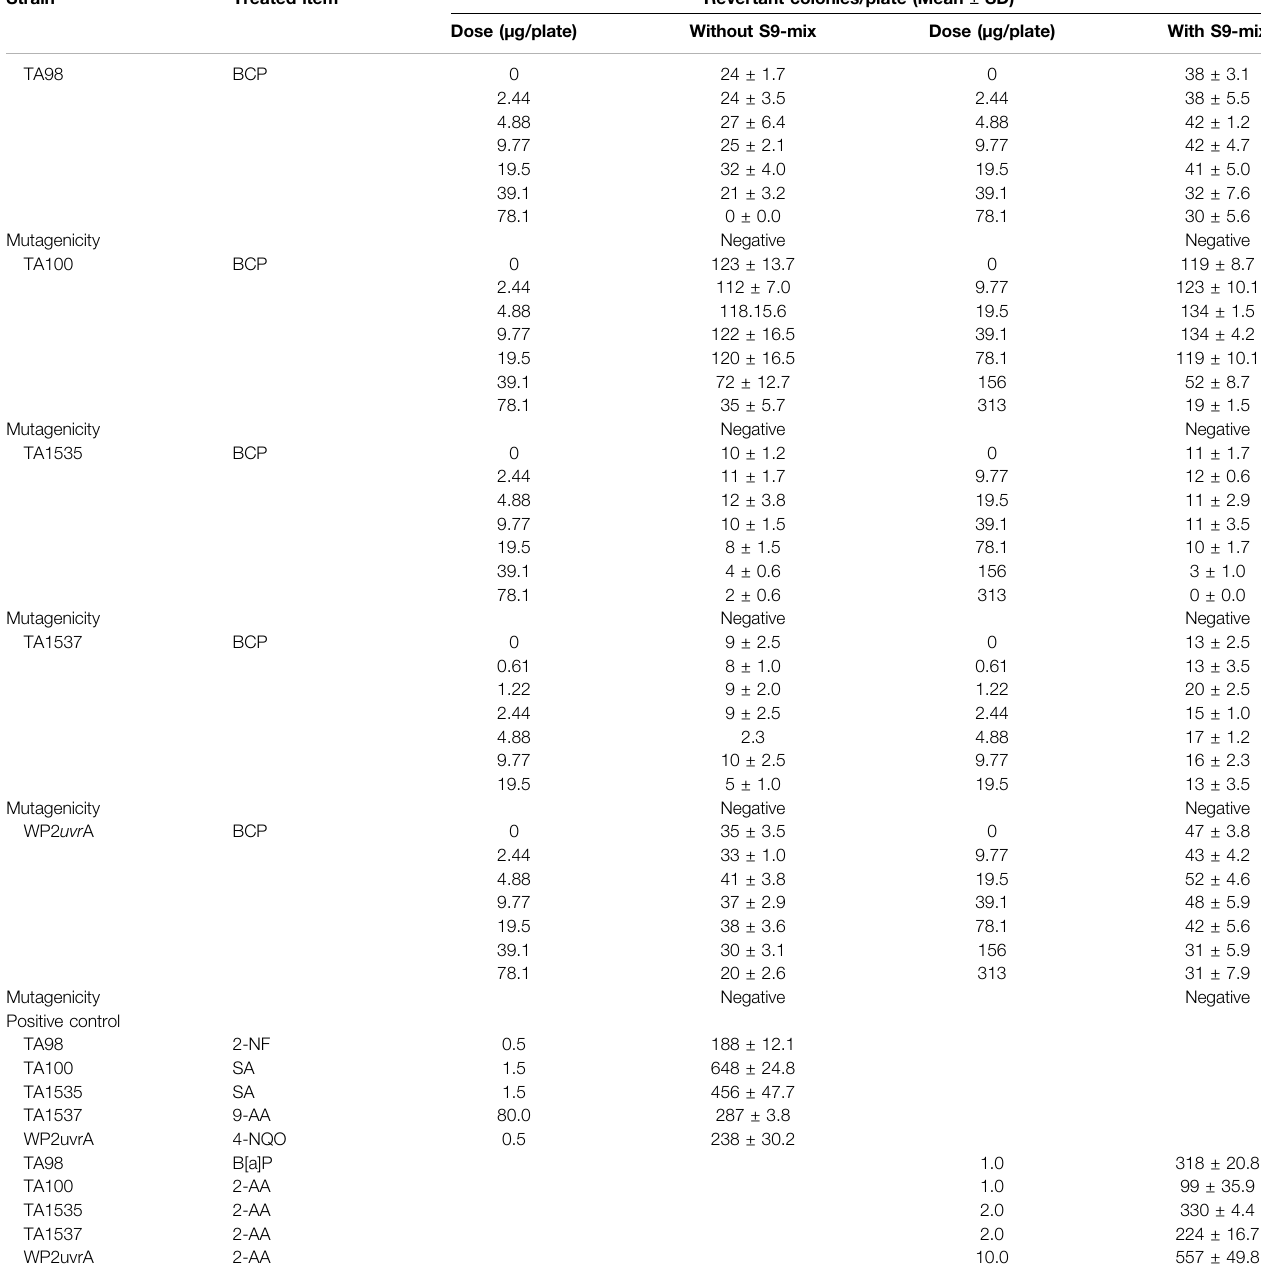
TABLE 6 | Bacterial reverse mutation test. Strain Treated